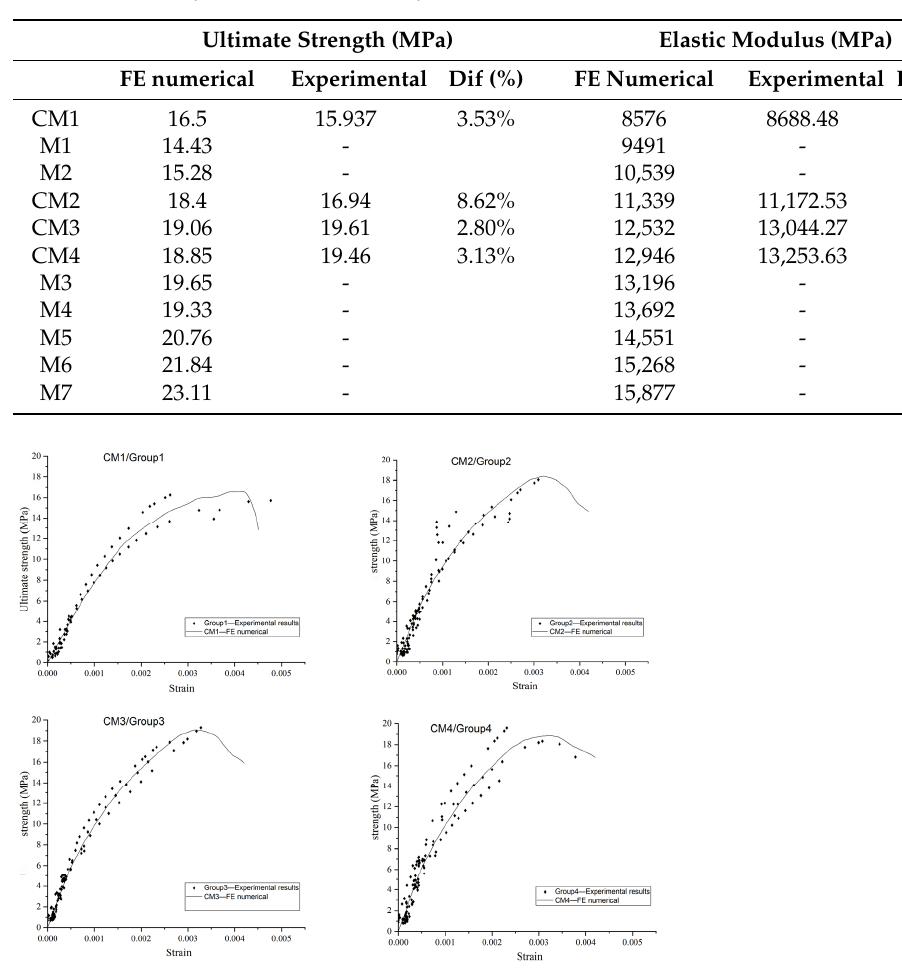
Table 12. Summary of FE numerical analysis results.